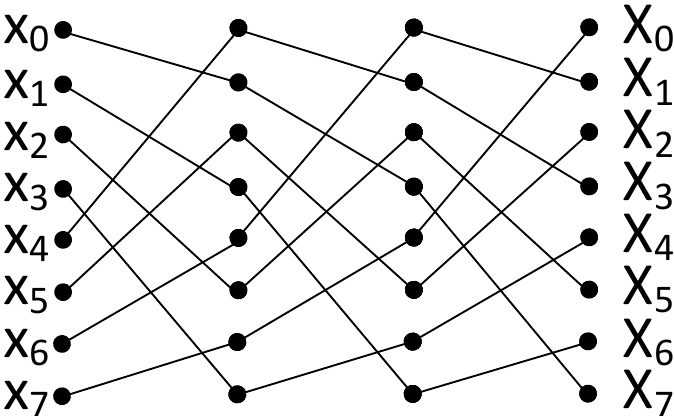
Figure 6. 8-point Singleton’s